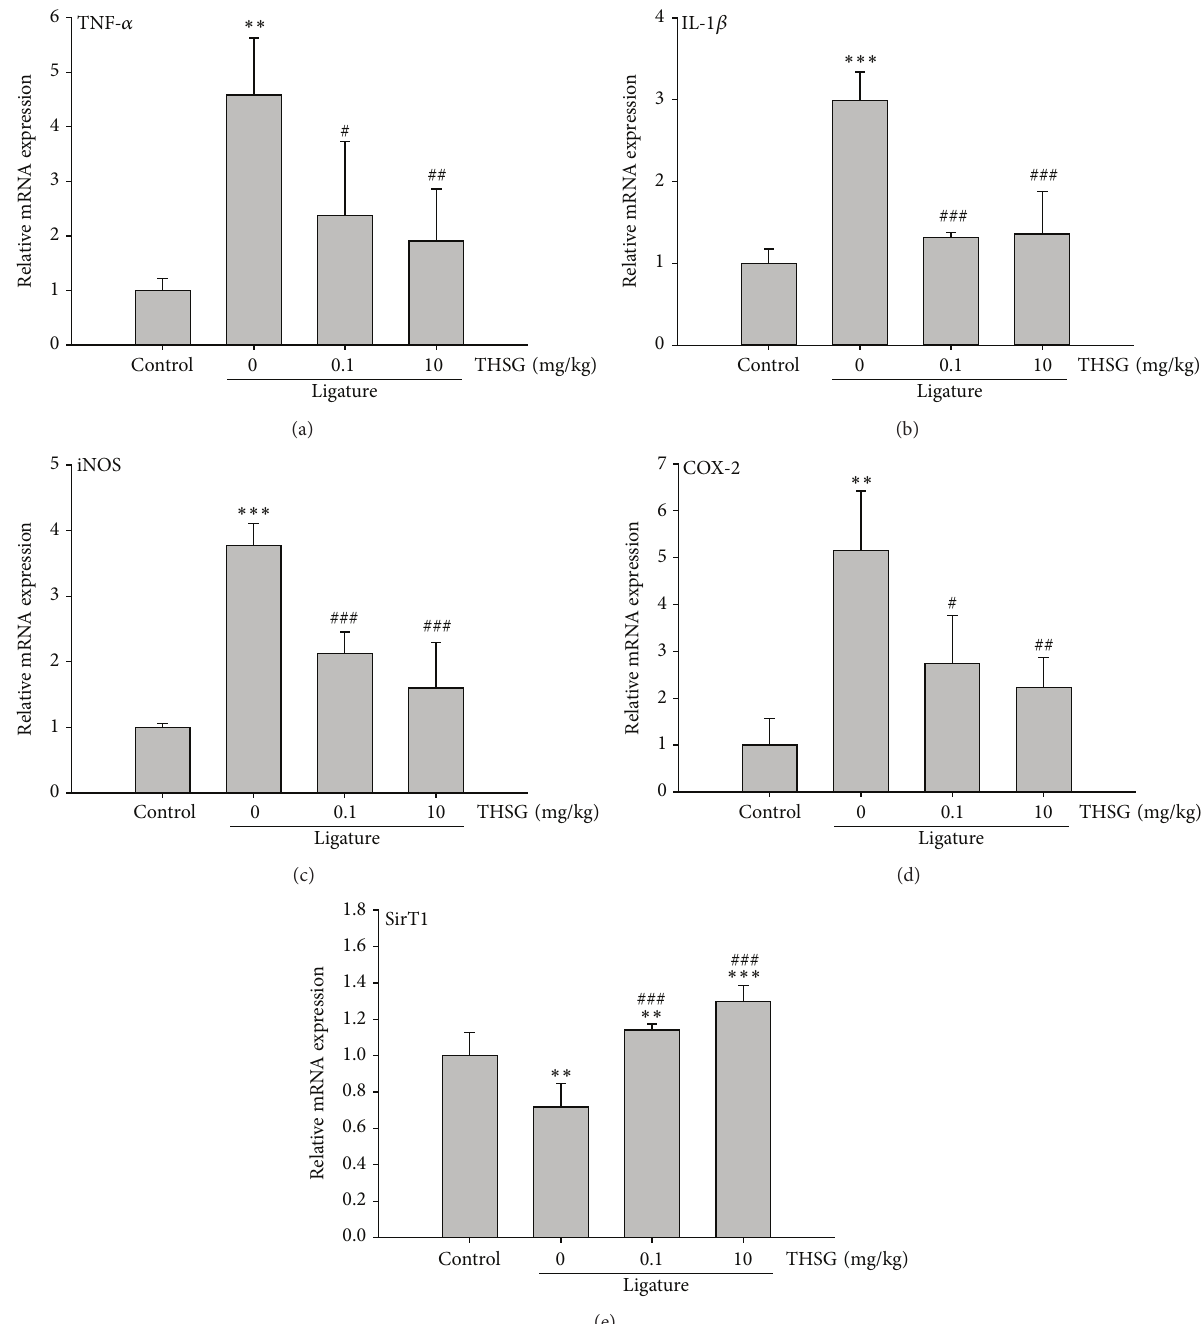
Figure 6: THSG attenuated the mRNA expression of proinflammatory cytokines and mediators in the gingival tissues of rats. Rat gingival tissues were collected from the first molars of mandible and homogenized. Their RNAs were extracted and reverse transcripted to cDNA. QPCRwasperformedtoexaminethemRNAexpressionofTNF- 𝛼 (a),IL-1 𝛽 (b),iNOS(c),COX-2(d),andSirT1(e).( ∗∗ 𝑝 < 0.01 ; ∗∗∗ 𝑝 < 0.001 were compared with control group. # 𝑝 < 0.05 ; ## 𝑝 < 0.01 ; ### 𝑝 < 0.001 were compared with 0 mg/kg THSG group.)